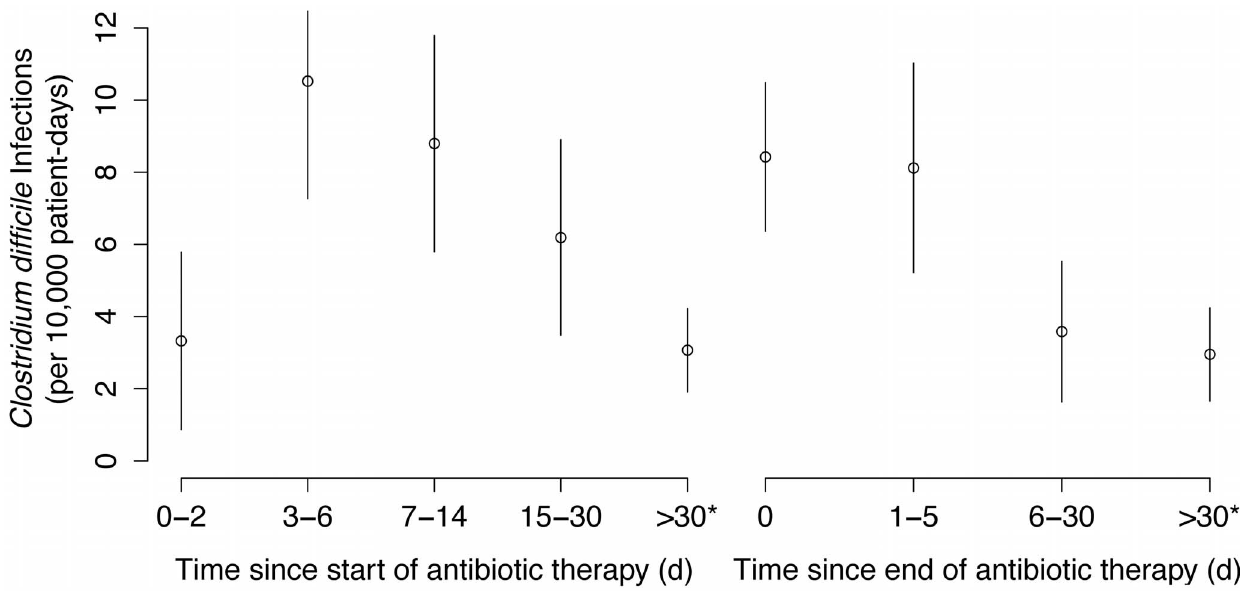
Figure 2. The Magnitude and Duration of Clostridiumdifficile Infection Risk After Antibiotic Therapy, Sunnybrook Hospital, Toronto, Canada, June 2010 to May 2012. Among inpatients, the incidence of Clostridium difficile infection was highest in the period 3 to 14 days after the start of antibiotic therapy, during antibiotic therapy, and within 5 days of the end of antibiotic therapy. * Includes patients without any identified antibiotic use.